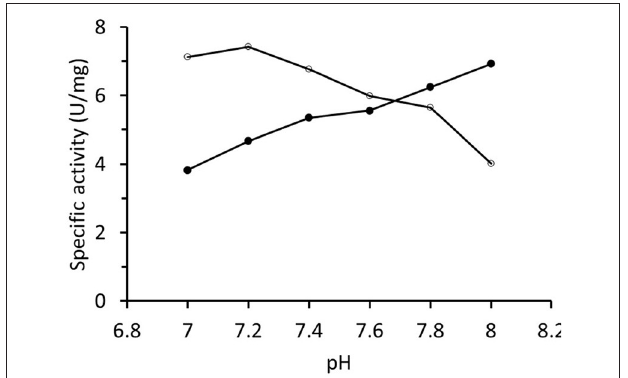
FIGURE 5 | Bioreduction of ACF to 1-phenylethanol in soluble RrADH and FDH system at variable amounts of enzyme in 1mL of the reaction mixture.